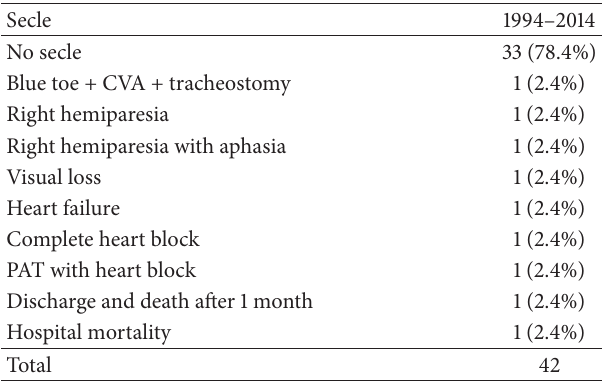
Table 4: Patients’ well-being in discharge time diagnosed with myxoma from 1994 to 2014 in Shahid Modarres